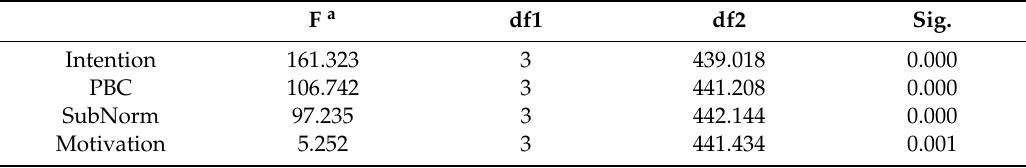
Table 4. Robust Tests of Equality of Means.